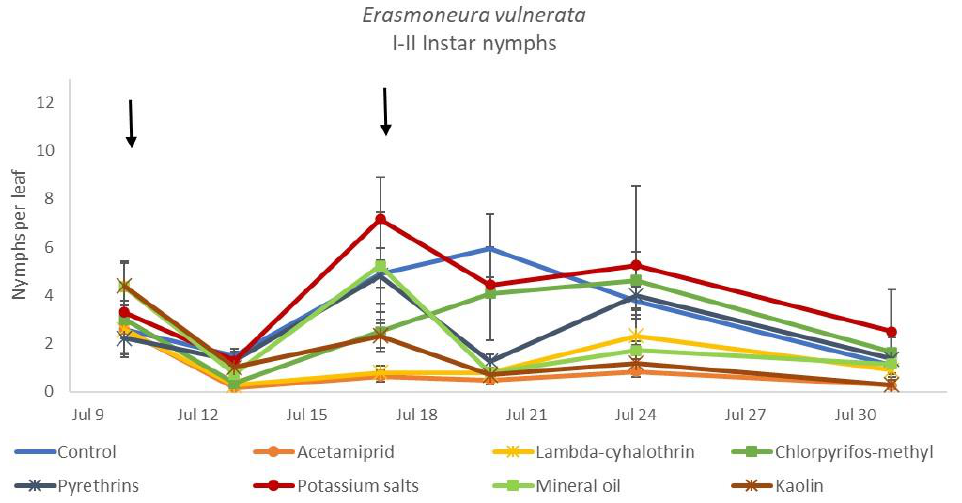
Figure 8. Dynamics of Erasmoneura vulnerata early (I-II instar) nymphs (mean ± std. err.) in the 2018 trial. Insecticides were applied one (first arrow) or two times (second arrow, see Materials and Methods section)